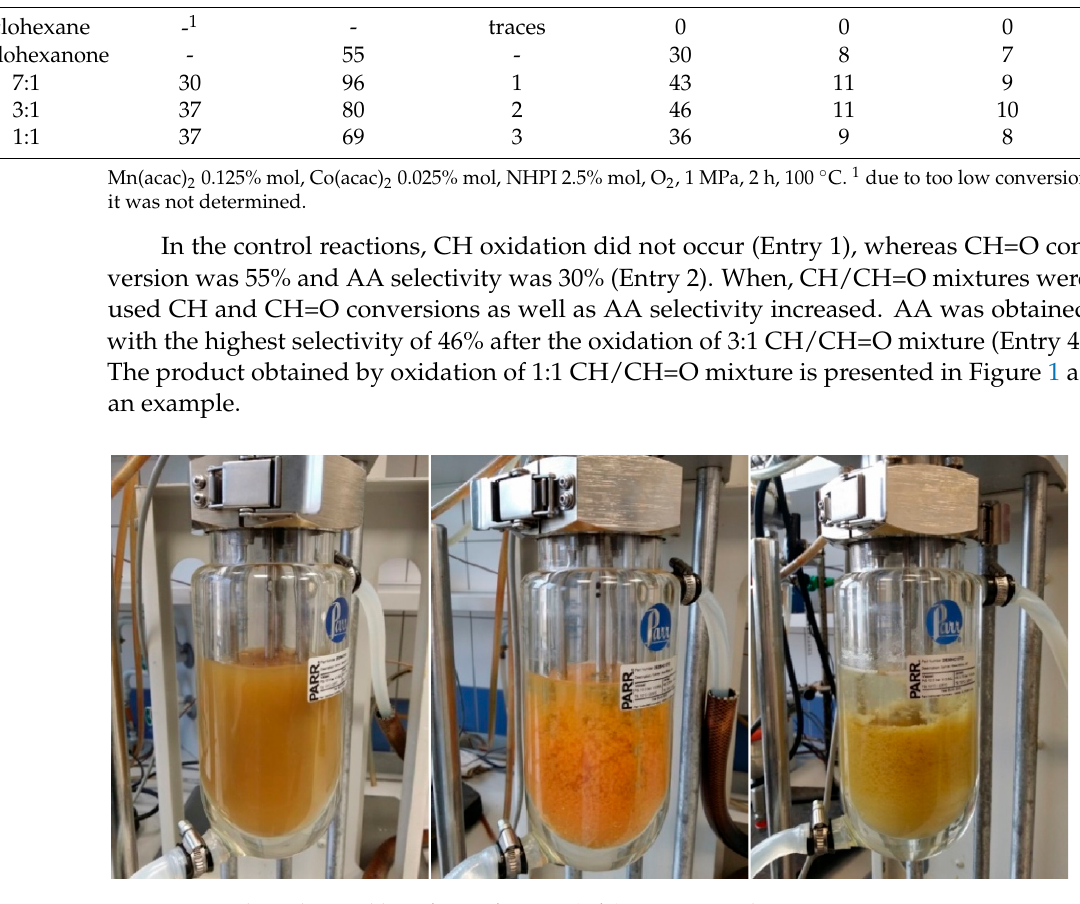
Figure 1. Product obtained by 1/1 CH/CH=O ( v / v ) mixture oxidation. The observed influence of CH/CH=O ratio was probably related to the change in